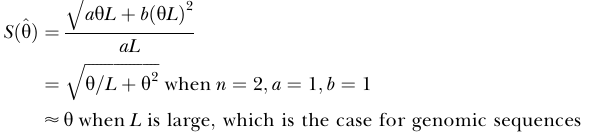
ffiffiffiffiffiffiffiffiffiffiffiffiffiffiffiffiffiffiffiffiffiffiffiffiffiffiffi q a h L þ b ð h L Þ 2 ffiffiffiffiffiffiffiffiffiffiffiffiffiffiffiffiffiffi h = L þ h 2